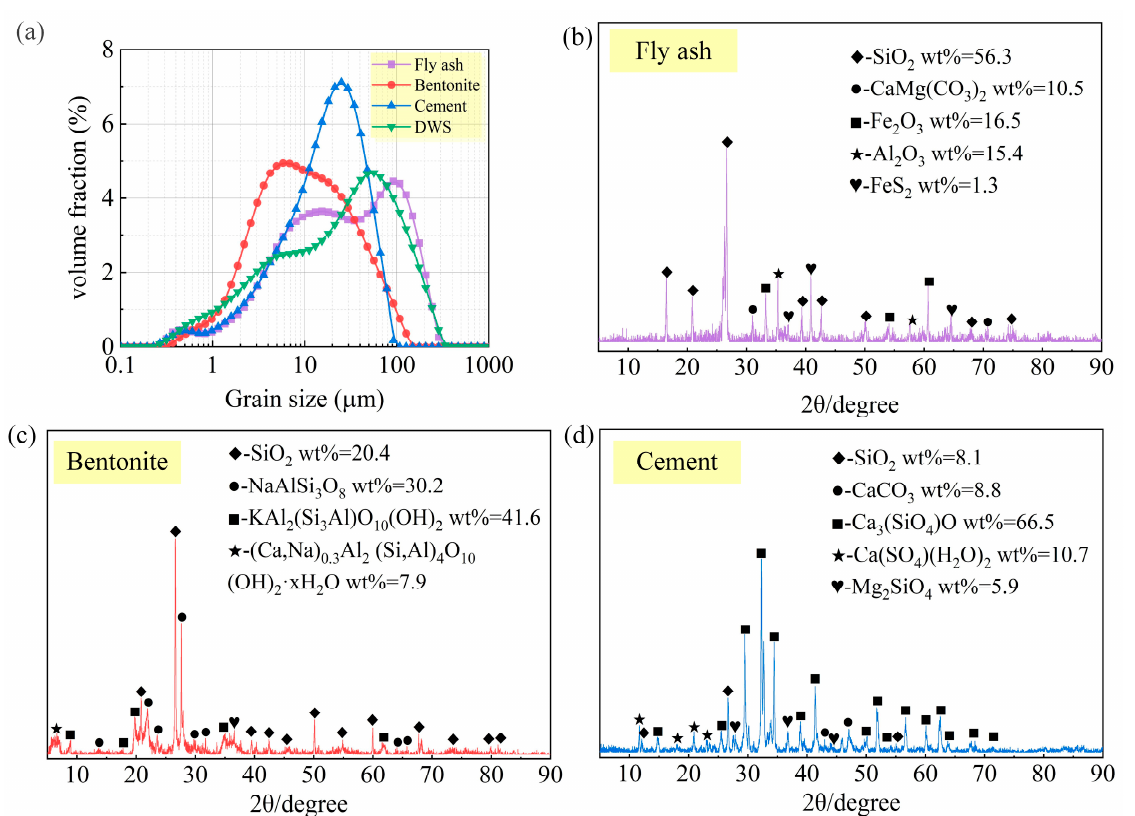
Table 2. The compositions of CE, BE, and FA.